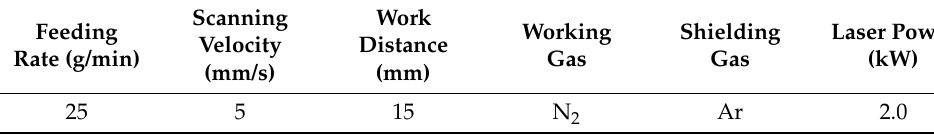
Figure 2. Schematic diagram: ( a ) GF process; ( b ) HF process. Table 5. Process parameters of GF.